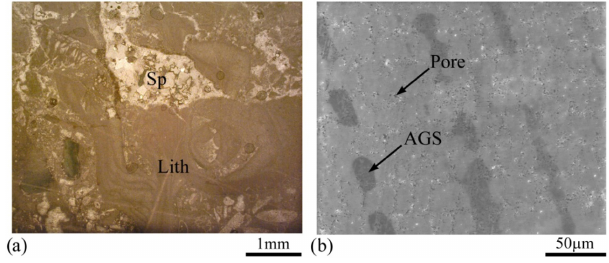
Figure 3. Textural characteristics of the Pietra Forte limestone: (a) lithotamnium algae (Lith) and sparry calcite cement (Sp), OM plane polarized light; (b) microporosity and algal growth structures (AGS), SEM image.